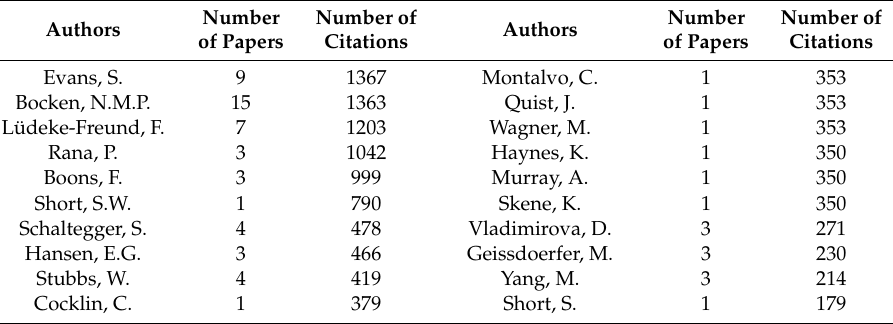
Table 9. Most cited authors in sustainable business models’